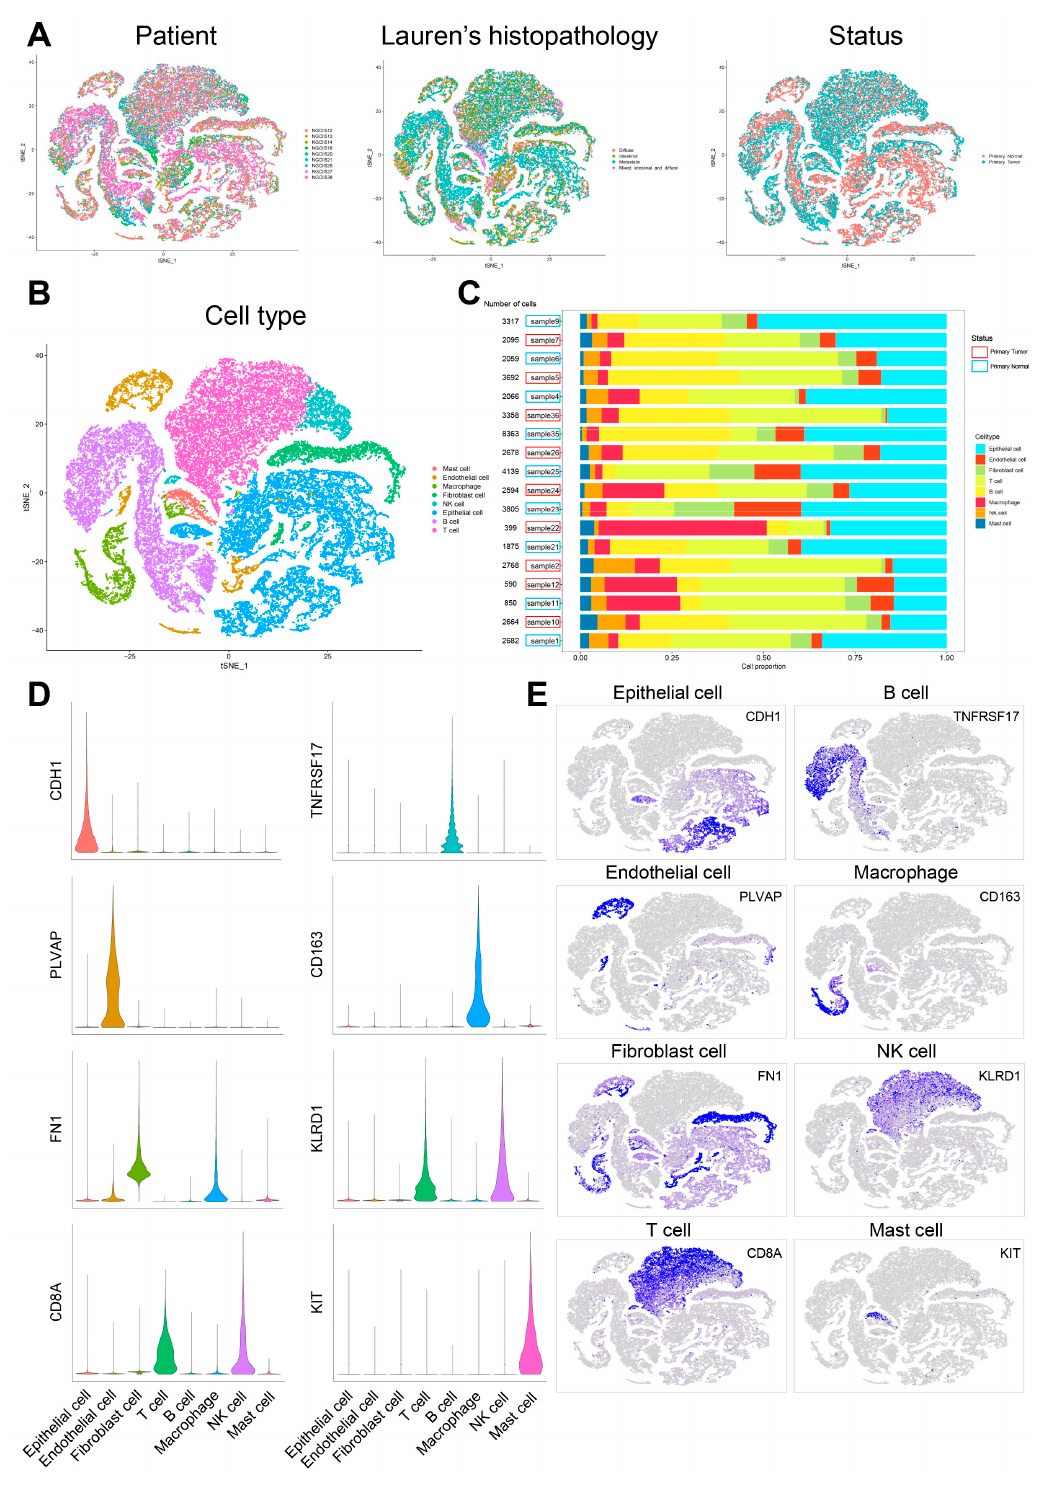
Figure 2. Cellular atlas of GC primary tumor and normal tissues. ( A ) tSNE plot for the 49,994 high − quality cells showing sample origin, Lauren’s histopathology and status. ( B ) tSNE plot show- ing cell types for the 49,994 cells. ( C ) The proportion of each cell type in 18 samples. ( D ) Violin plots showing the expression distribution of marker genes in eight cell types. ( E ) tSNE plots showing the expression levels of marker genes for eight cell types.